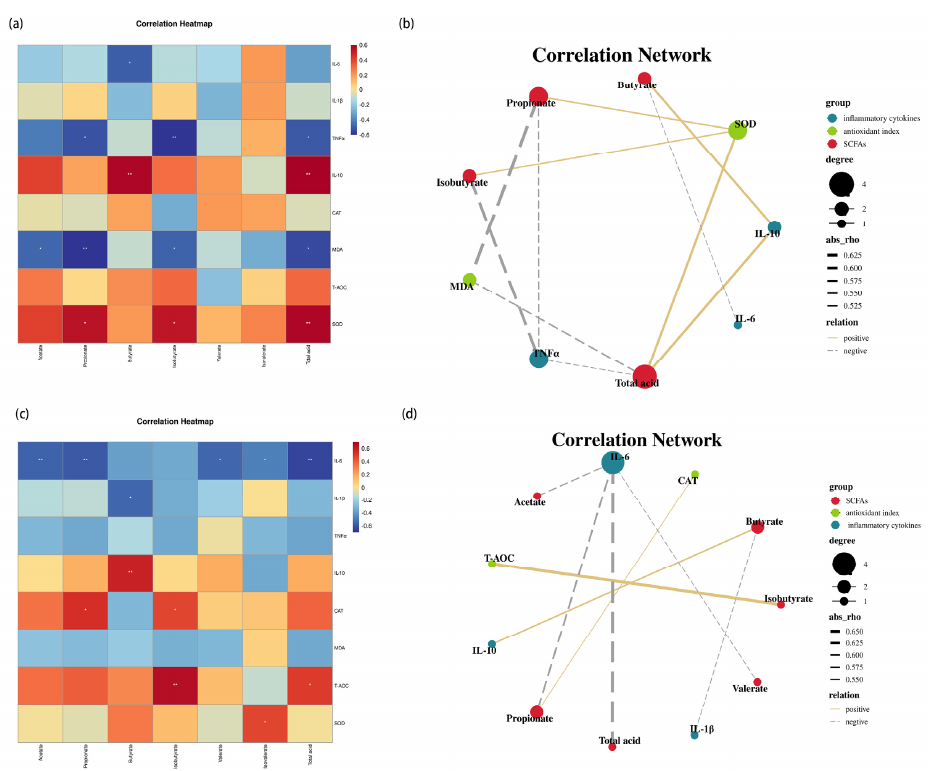
Figure 5. Correlation heatmap ( a ) and Correlation network ( b ) between SCFAs and inflammatory cytokines, and antioxidant indexes in the jejunum; Correlation heatmap ( c ) and Correlation network ( d ) between SCFAs and inflammatory cytokines, and antioxidant indexes in the ileum. * p < 0.05 and ** p < 0.01.